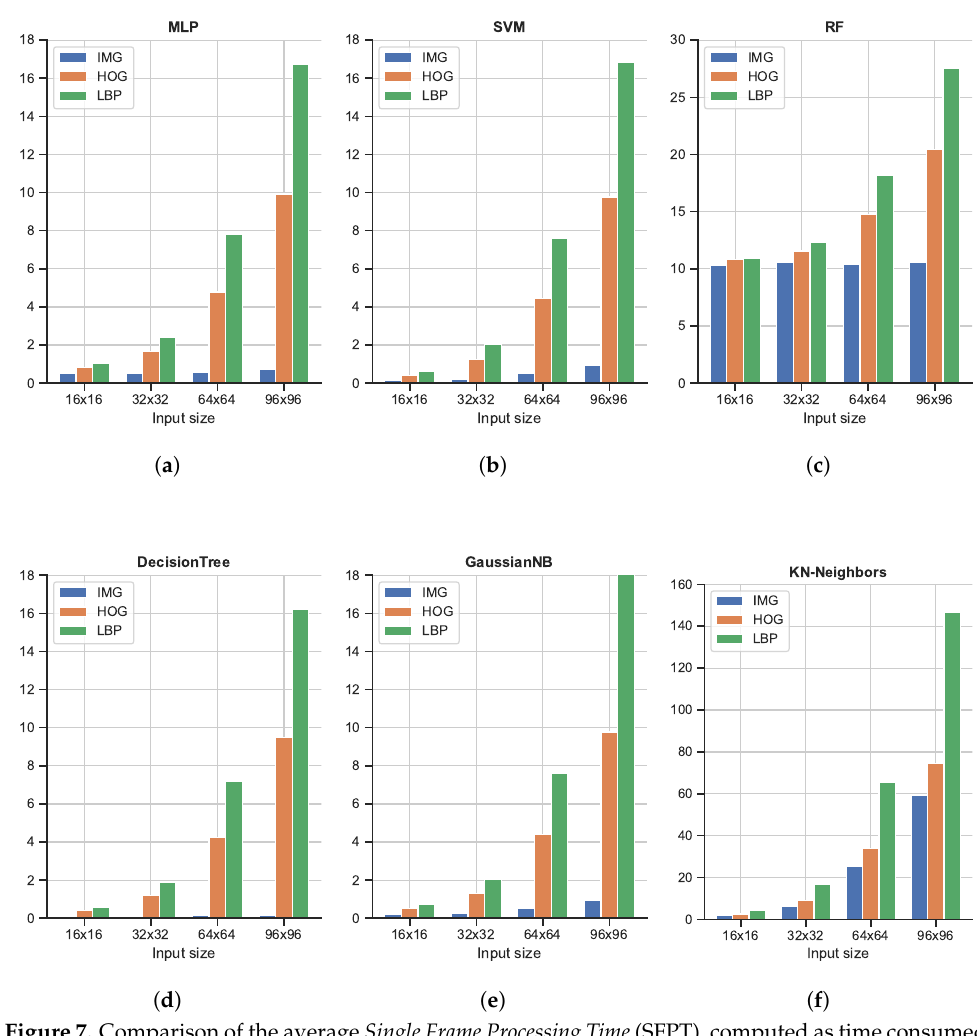
Figure 7. Comparison of the average Single Frame Processing Time (SFPT), computed as time consumed for the feature extraction process plus the prediction time, of the three Machine Learning-based classifiers running on a Desktop computer. ( a ) Shows Multi-Later Perceptron (MLP) classifier times, ( b ) Support Vector Machine (SVM) classifier, ( c ) Random Forest (RF), ( d ) Decision Tree classifier, ( e ) Gaussian Naive Bayes (GaussianNB) classifiers, and ( f ) K-nearest neighbors (KN-neighbors) classifier. The time values are expressed in milliseconds